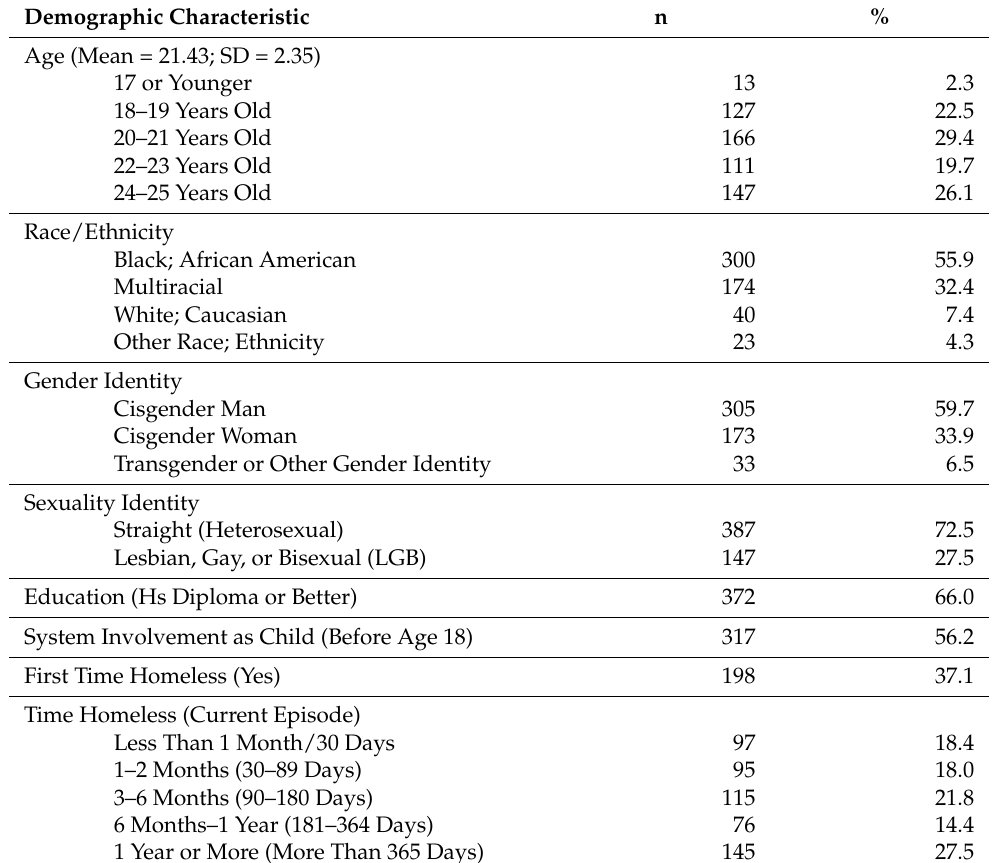
Table 2. Demographic profile of runaway and homeless youth (RHY) participants, 2018 Atlanta Youth Count (n =